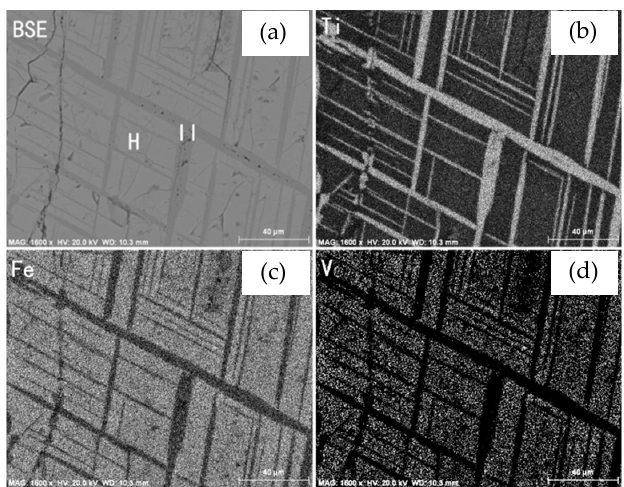
Figure 1. SEM images of vanadium-titanium magnetite replaced by martite: ( a ) Back-scattered electron image; ( b ) Ti element mapping; ( c ) Fe element mapping; ( d ) V element mapping.